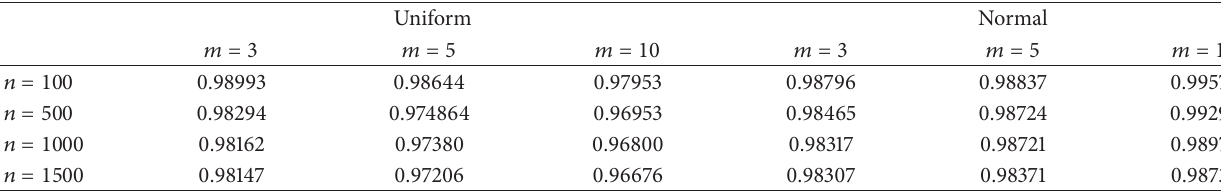
Table 3: Z(LB4)/Z(LB3) in the SPTA-F sequence.